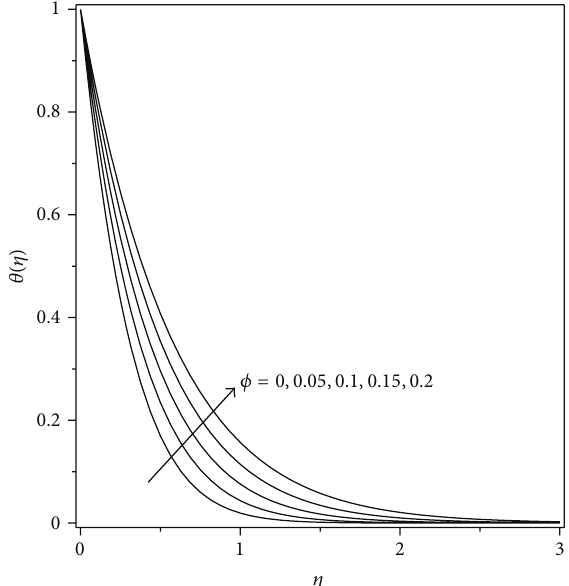
Figure 7: Dimensionless temperature profiles 𝜃(𝜂) for Cu nanopar- ticles with 𝑚 = 0 and various values of 𝜙